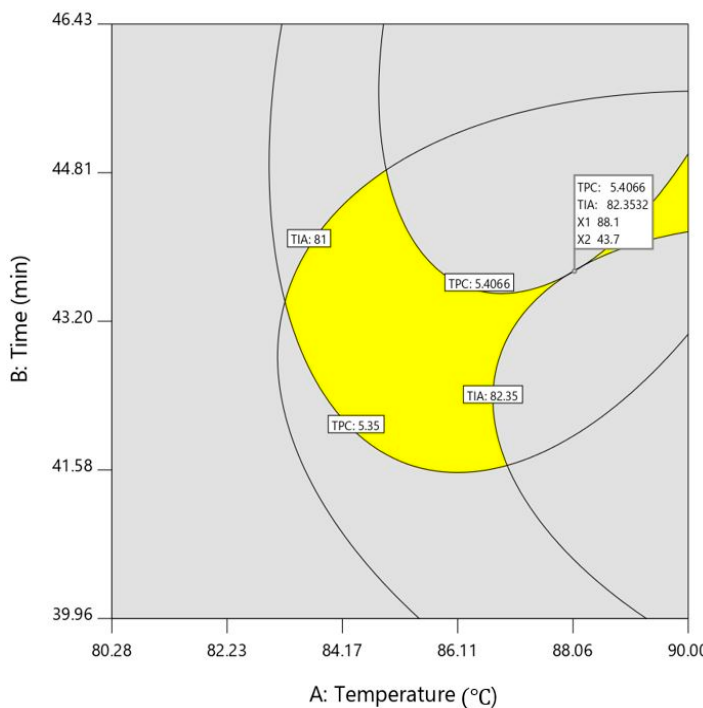
Figure 4. Overlay plot for the optimal region (best combination) of the extraction temperature and time, for the prediction of maximum levels of TPC and TIA.